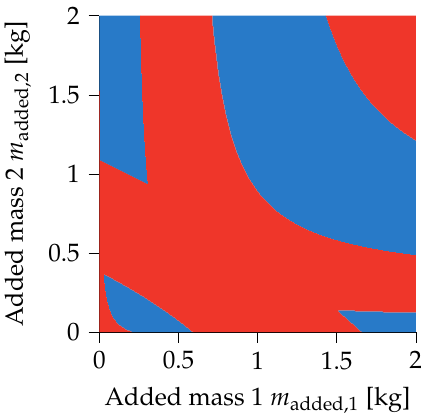
Figure 5. Design domain of the two-mass oscillator with valid design domain in blue and invalid design domain in red demonstrating islands of validity